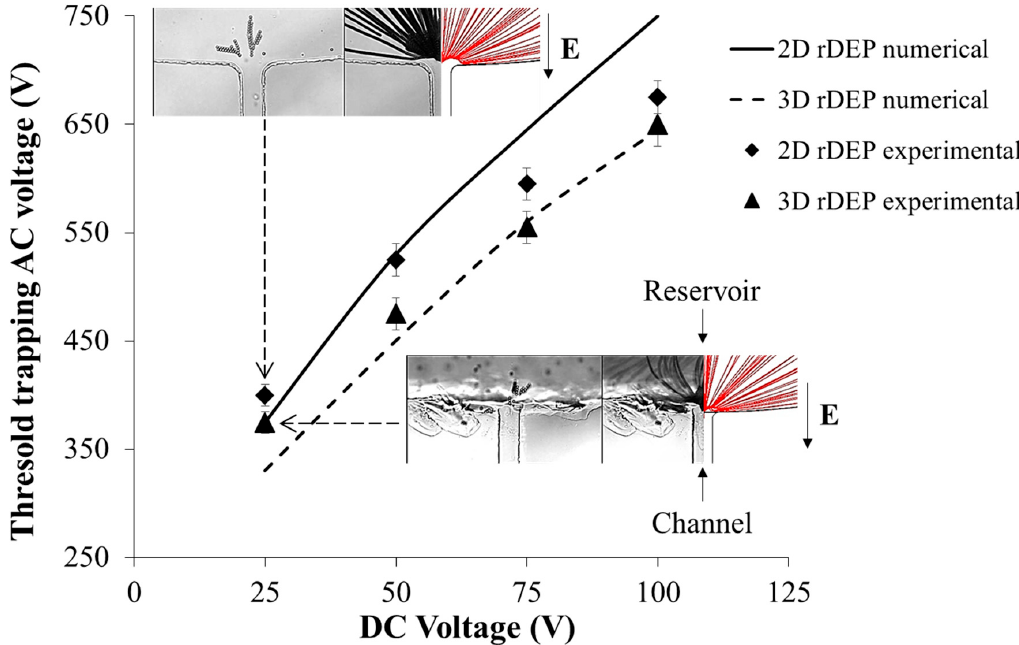
Figure 5. Graphical representation of the variation of the threshold AC voltage required to trap the 5µm beads as a function of the applied DC voltage in the 2DrDEP and the 3DrDEP devices. The applied DC voltages are varied from 25 V to 100 V in steps of 25 V, while the AC voltage is varied from 0 V until the value where trapping is achieved. The inset images represent the comparison of experimentally obtained and numerically predicted path-lines for an applied DC voltage of 25 V DC plotted in the top view (X-Y). Observe the significant reduction in the AC voltage required for trapping inside the 3DrDEP device over that in the 2DrDEP device. This is because of the strong additional depth-wise component of the electric field gradients produced in the former, which reduces the requirement of applied voltage for producing comparable DEP forces.